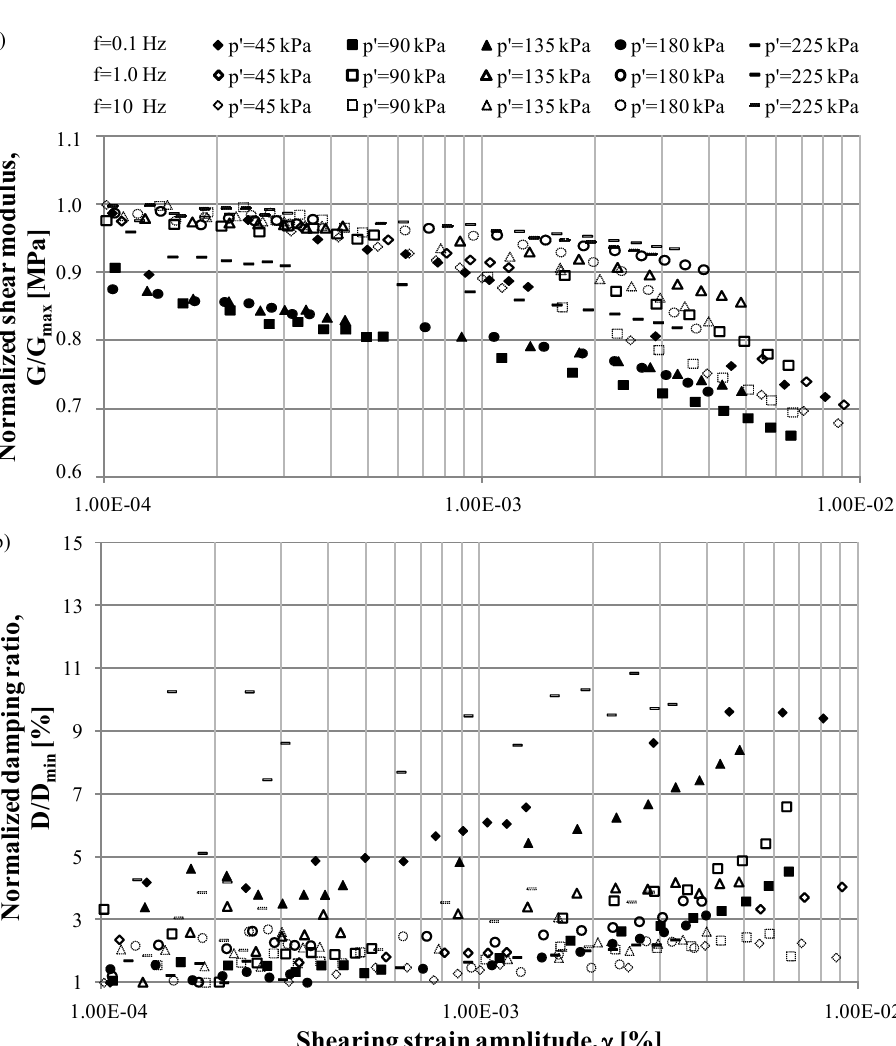
Fig. 9. Normalized shear modulus (a) and normalized damping ratio (b) as a function of shearing strain amplitude for test